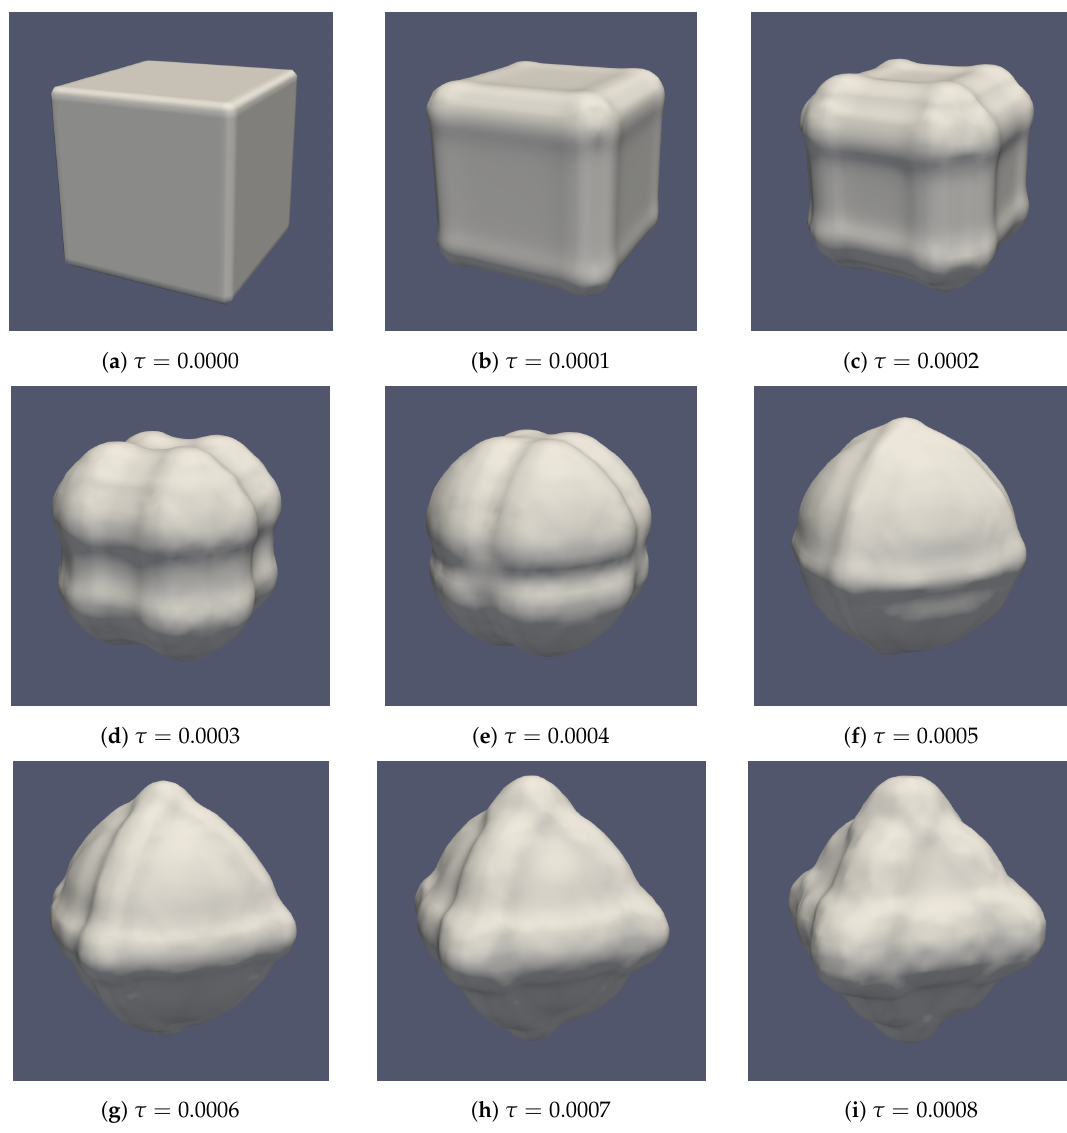
Figure 8. A series of an oscillating droplet in zero gravity